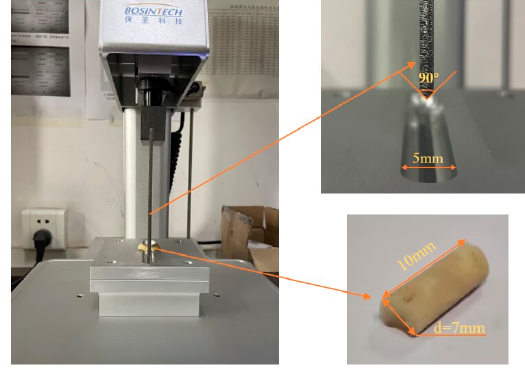
Figure 2. The damage test of the walnut kernel.